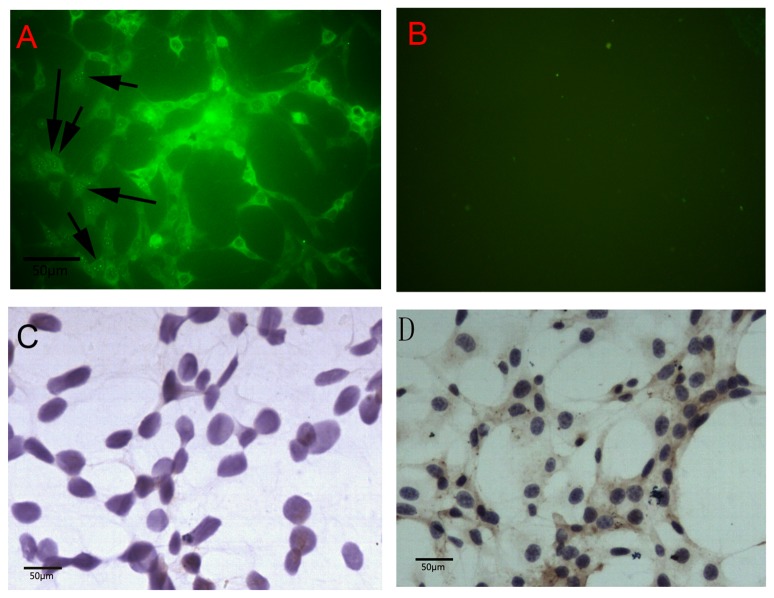
Expression of Pelp1 protein in rat bone marrow mesenchymal stem cells (rBMSCs) cultured in
vitro for 4 days.(A) Immunofluorescence staining (×200) showed that Pelp1 was predominantly localized in cytoplasm rather than nuclei in undifferentiated rBMSCs. The arrows show Pelp1-positive staining localized in nuclei. (B) Isotype control. (C) Immunocytochemistry staining (×200) showed Pelp1-negative staining in rBMSCs using Pelp1 blocking peptide. (D) Immunocytochemistry staining (×200) showed Pelp1 positive staining in rBMSCs using Pelp1 antibody.